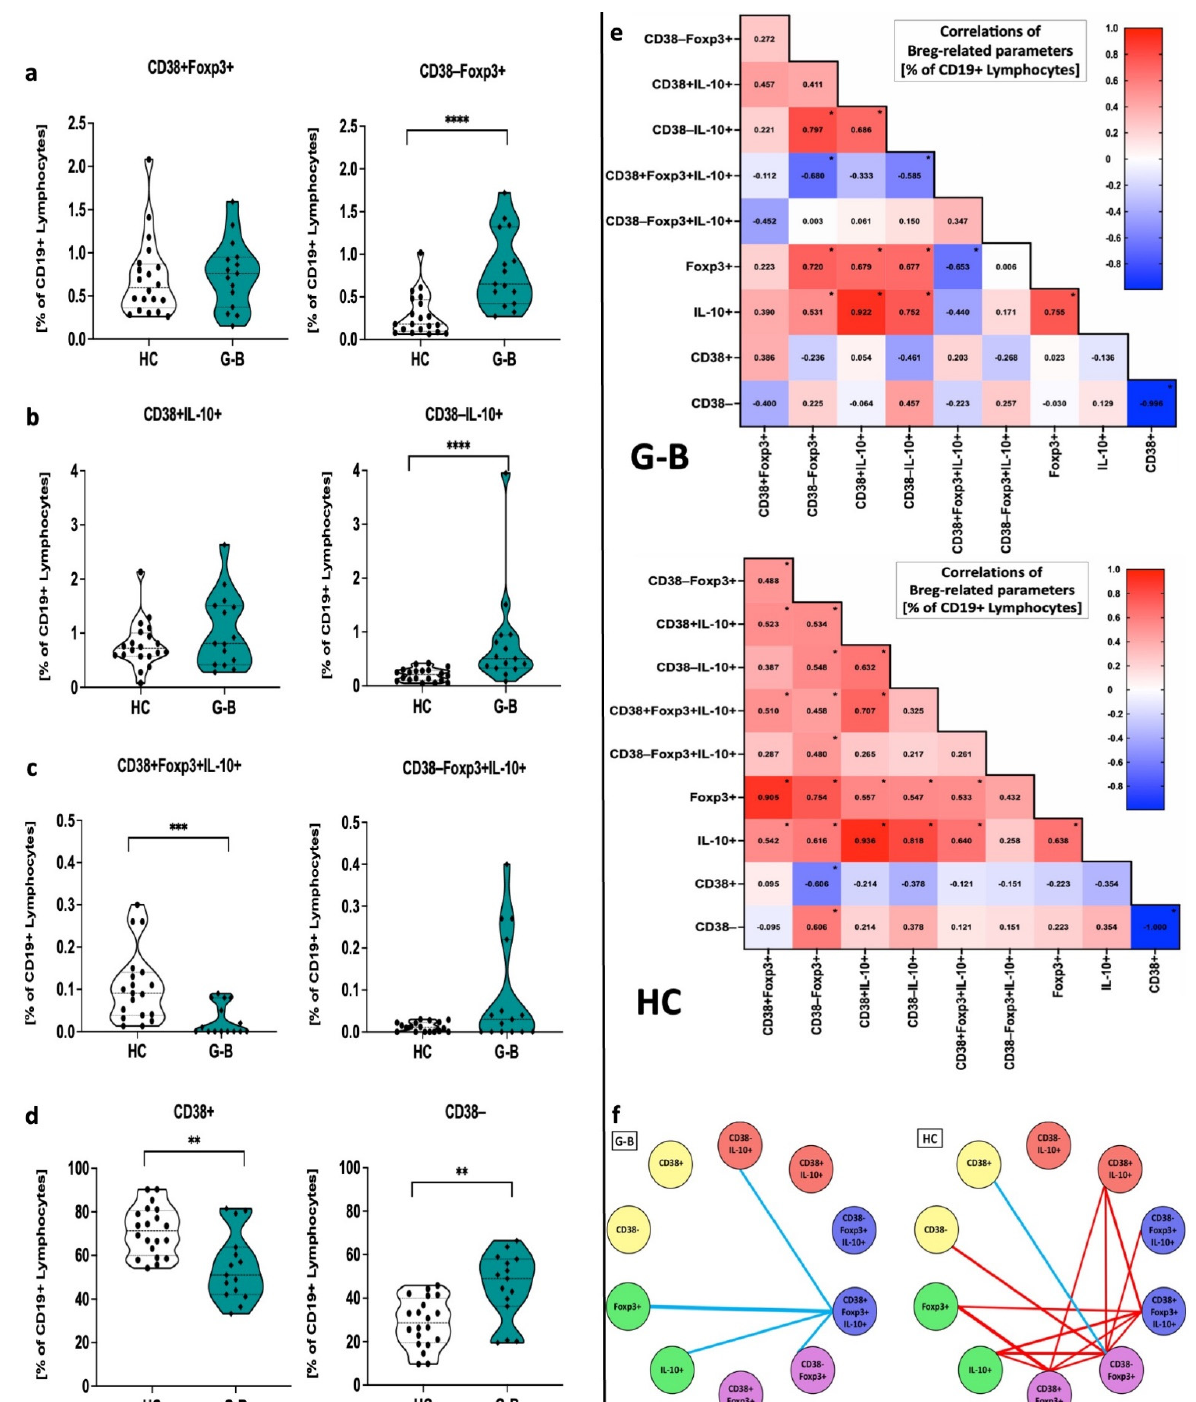
Figure 2. Variations in regulatory B cell frequencies in Graves’ patients and healthy control subjects. Regulatory B cell subsets were presented as B cells with/without the presence of CD38 marker and expression of Foxp3 ( a ), IL-10 ( b ), co-expression of Foxp3, and IL-10 ( c ). Changes in cells demonstrating CD38 within CD19+ B cells were also included ( d ). Data are presented on each graph as mean with standard deviation. Significant data are indicated with asterisks: * p < 0.05, ** p < 0.01, *** p < 0.001, **** p < 0.0001. Mutual associations between Breg-related parameters were established individually within Graves’ and healthy control subjects and presented as r values on heat maps ( e ). Significantly different connections between parameters within Graves’ and control patients were visualized following exclusion of overlapping links ( f